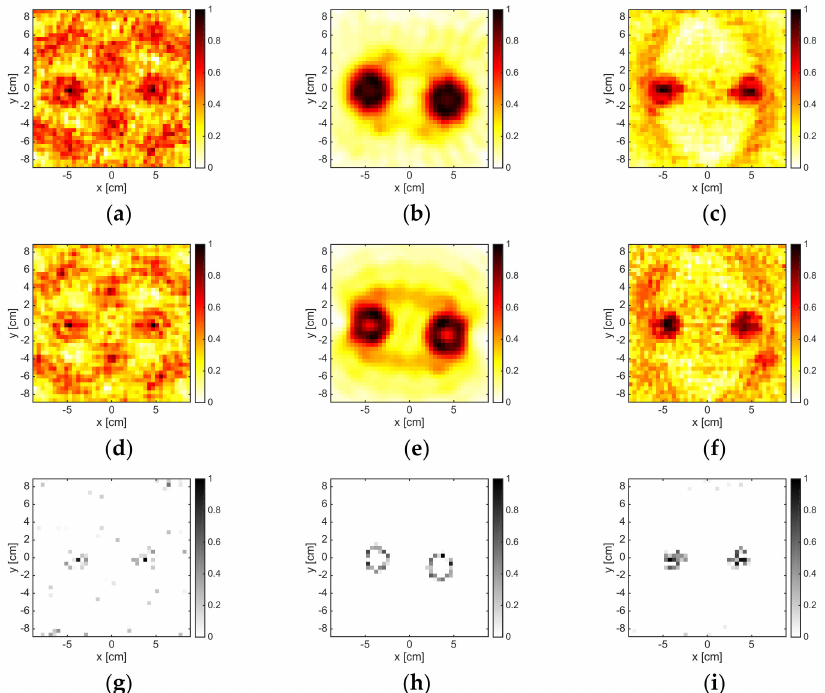
Figure 9. The TwinDielTM target. From left to right: 16 GHz (M = 18), 8 GHz (M = 36), and 16 GHz (M = 36). From top to bottom: LSM, OSM, and boundary indicators. The number of measurements and views was M = 18 for the first column and M = 36 for the last two